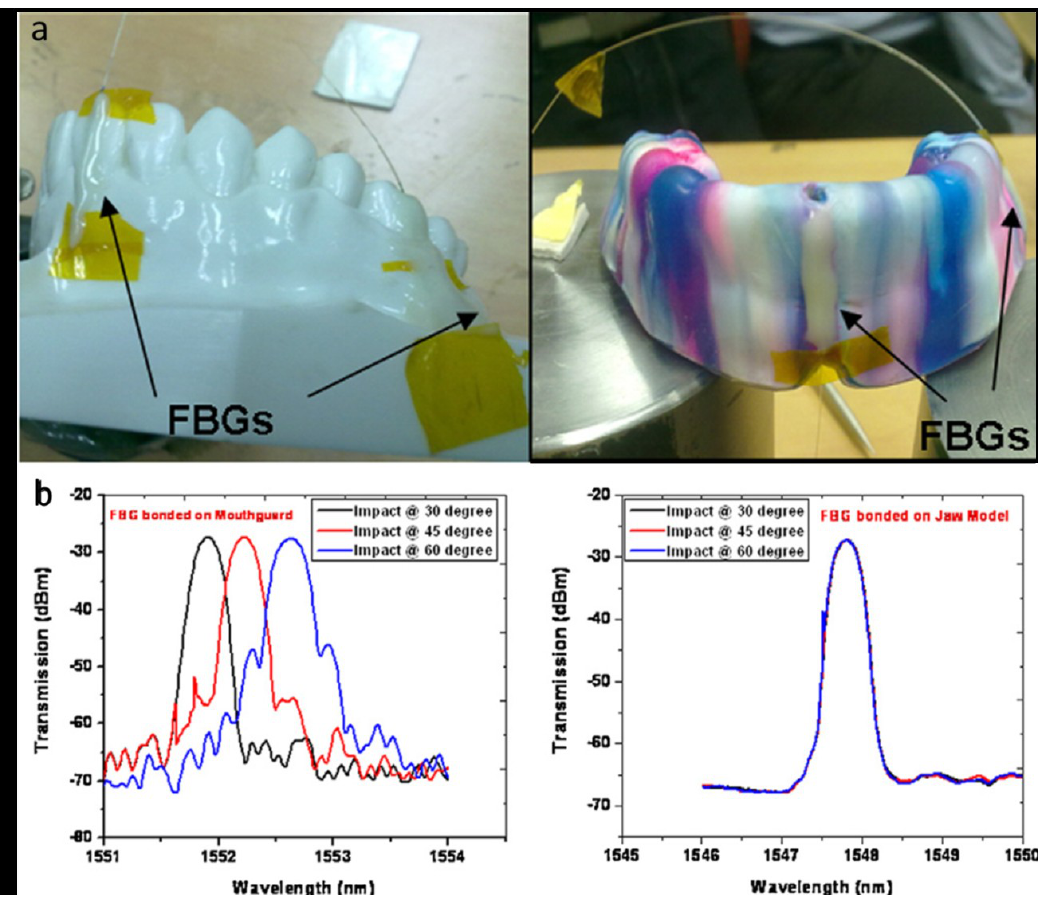
Figure 10. ( a ) The jaw model and mouthguard with FBGs. ( b ) The response of ball impact portraying no changes for FBG bonded on jaw model ( b right ) as compared to FBG bonded on the mouthguard ( b left )